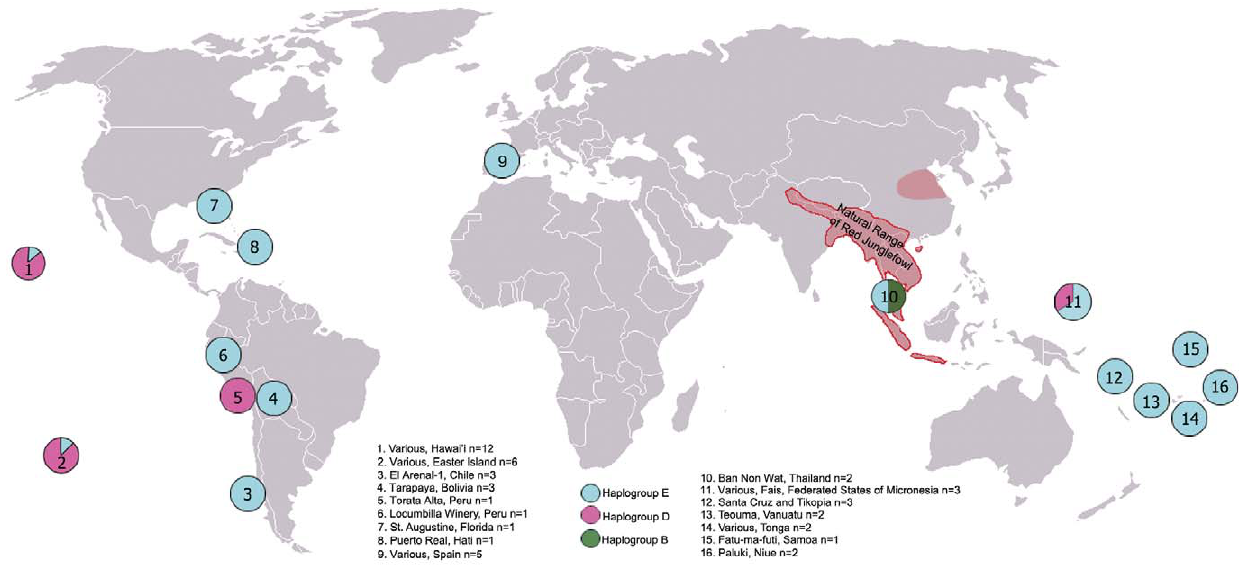
Figure 2. Map showing the relative proportions of haplogroups sequenced from archaeologically derived remains. Each pie represents 100% of the sequences obtained and the numbers inside each pie refer to the legend which details the geographic provenience and the number of samples from each area. Each colour represents one of three distinct haplogroups. The natural range of Red Junglefowl is outlined in red and represents the area in which initial domestication events must have occurred [8,21]. The red shaded area in northern China represents an area in which G. gallus bones have been recovered from archaeological sites older than 5000 BC. This has led to debate about whether the natural range of Red Junglefowl in prehistory extended further north